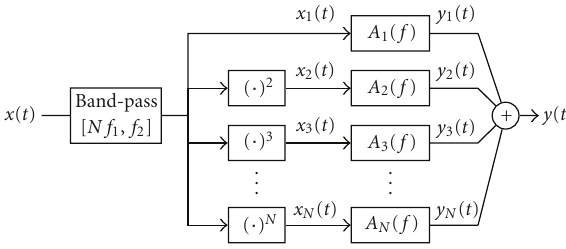
Figure 3: Generalized Polynomial Hammerstein (GPH) model (power series nonlinear model) for nonlinear system